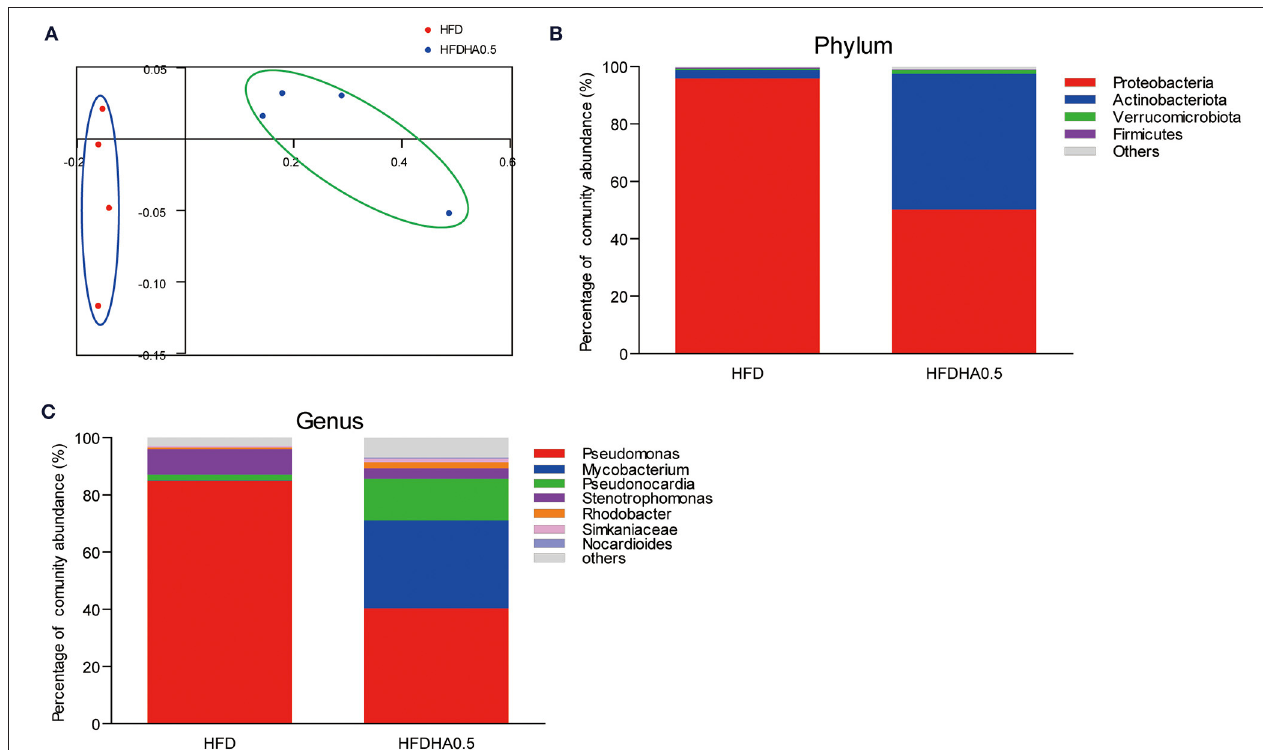
FIGURE 7 | Effects of DHA supplementation on gut microbial community in zebrafish. (A) PCoA analysis of gut microbiota in HFD- and HFDHA0.5-fed zebrafish. (B) Relative abundance at the phylum level of gut microbial community from HFD- and HFDHA0.5-fed zebrafish (C) Relative abundance at the genus level of gut microbial community from HFD- and HFDHA0.5-fed zebrafish. Values are means ± SEMs ( n = 4 biological replicates).